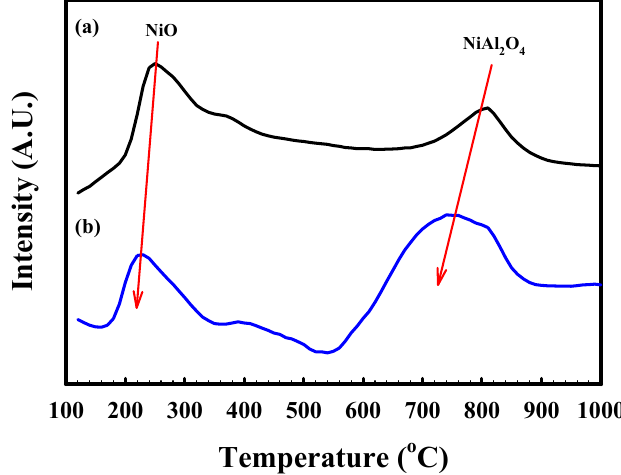
Figure 2. Temperature-programed reduction (TPR) profiles of the NA10-PM catalyst under ( a ) H 2 -reduction and ( b ) auto-reduction condition.